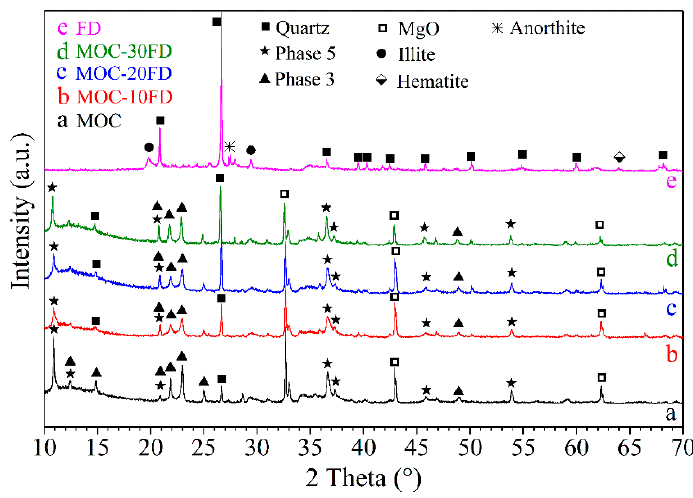
Figure 2. XRD patterns of different samples: a. pure MOC; b. FD/MOC composites containing 10 wt.% of FD; c. FD/MOC composites containing 20 wt.% of FD; d. FD/MOC composites containing 30 wt.% of FD; e. FD powders.